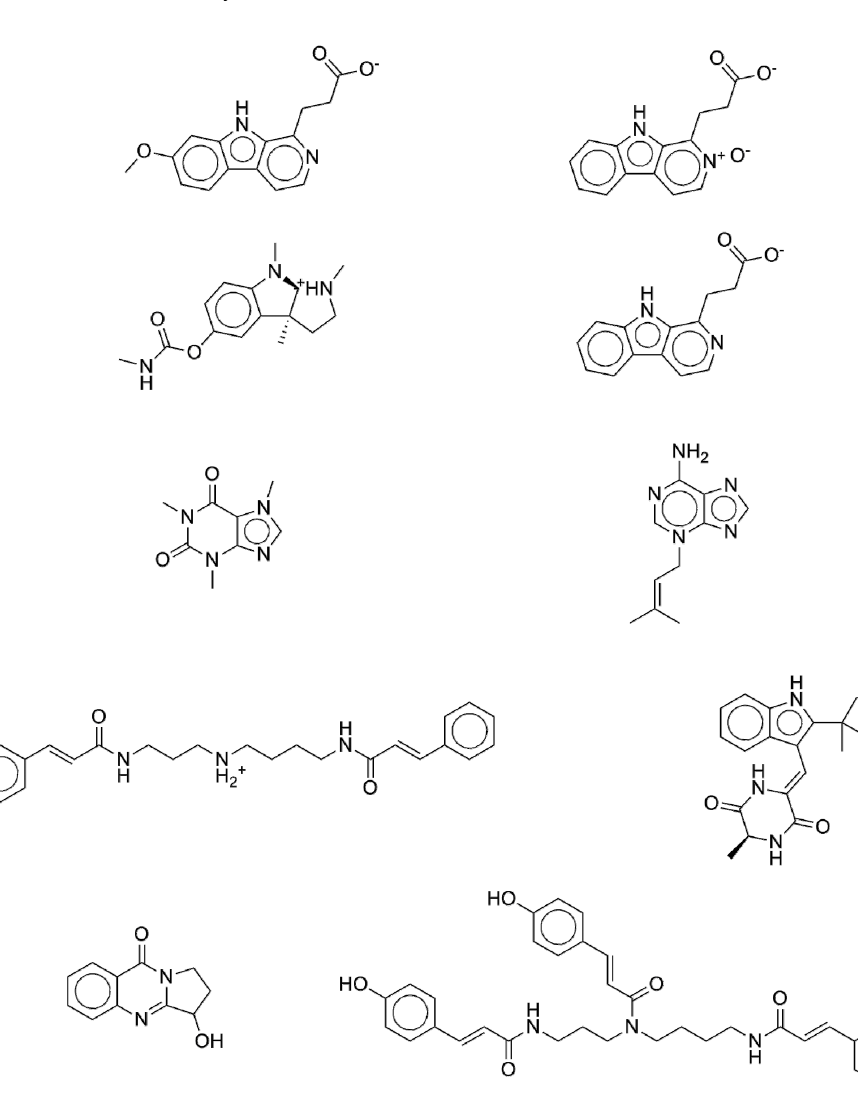
Figure 9. Some of the natural products that scored highly as potential anti-diabetic drug candidates according to our ISE-based, anti-diabetic activity indexing model.